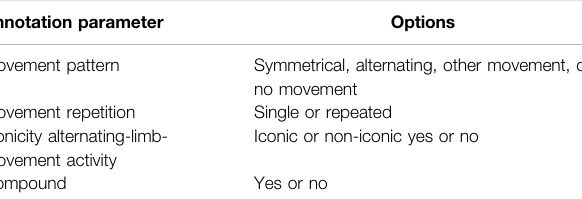
TABLE 1 | Annotation parameters for two-handed balanced